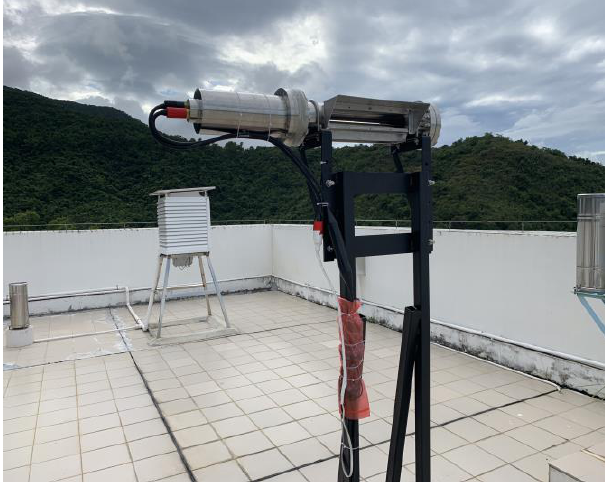
Figure 12. A photograph of the scanned-WMS- θ 1f instrumental set-up.